Question: Compose a caption that would accompany this figure in a paper.
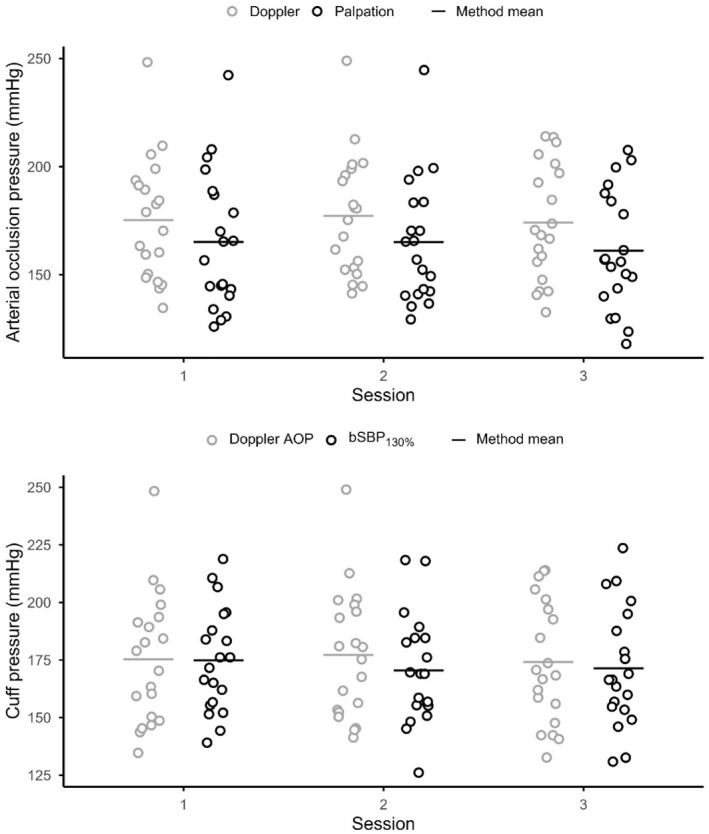
Answer: Comparison of individual AOP values per testing session. Top panel = AOP assessed with Doppler ultrasound and palpation. Bottom panel = AOP assessed with Doppler ultrasound and 130% brachial systolic blood pressure (130%SBP).